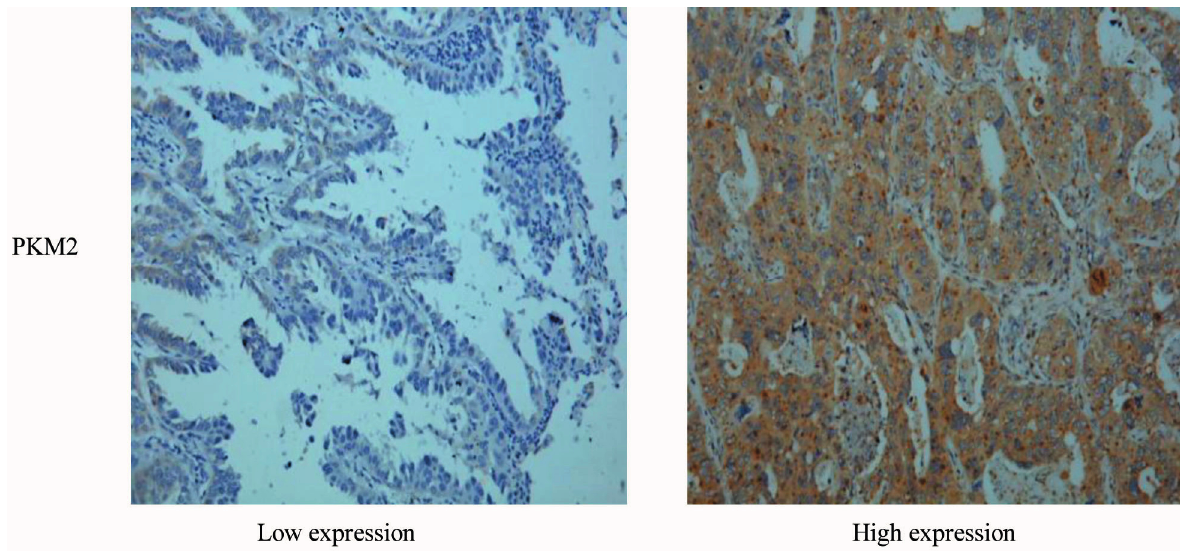
Figure 1. PKM2 expression in representative tumor tissues (magnification,